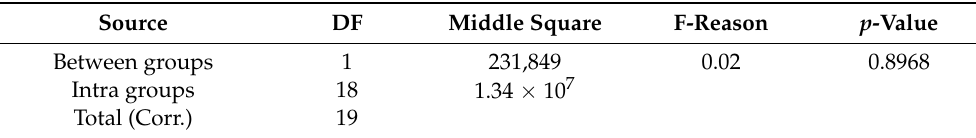
Table 10. Analysis of variance (ANOVA) results ANN model. Source DF Middle Square F-Reason p -Value Between groups 1 231,849 0.02 Intra groups